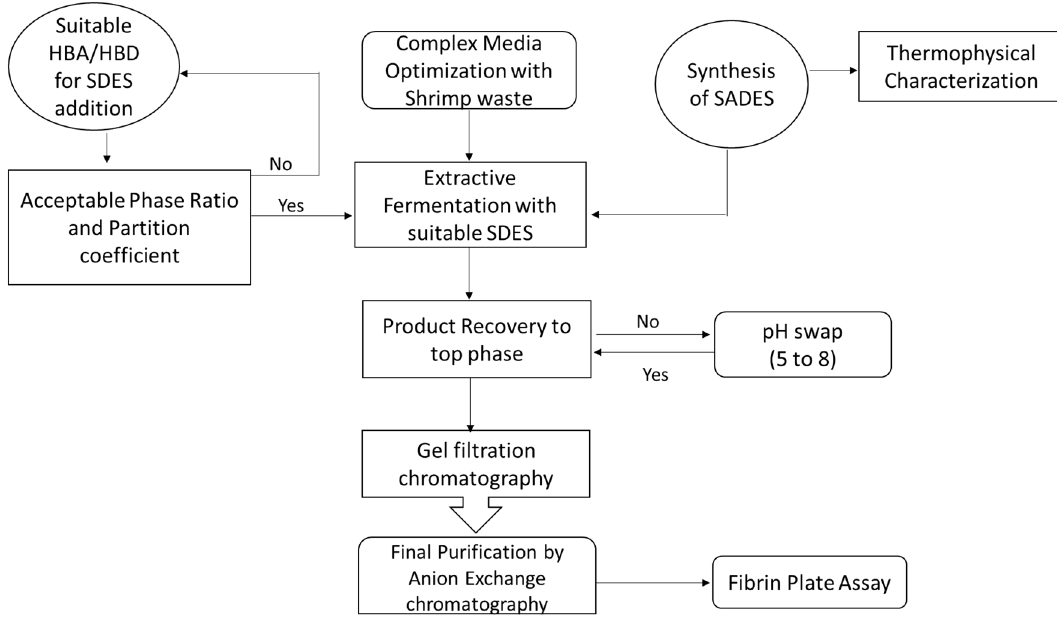
Figure 1. Schematic algorithm of swappable pH extractive fermentation for selective purification of fibrinolytic protease using surfactant based deep eutectic solvents